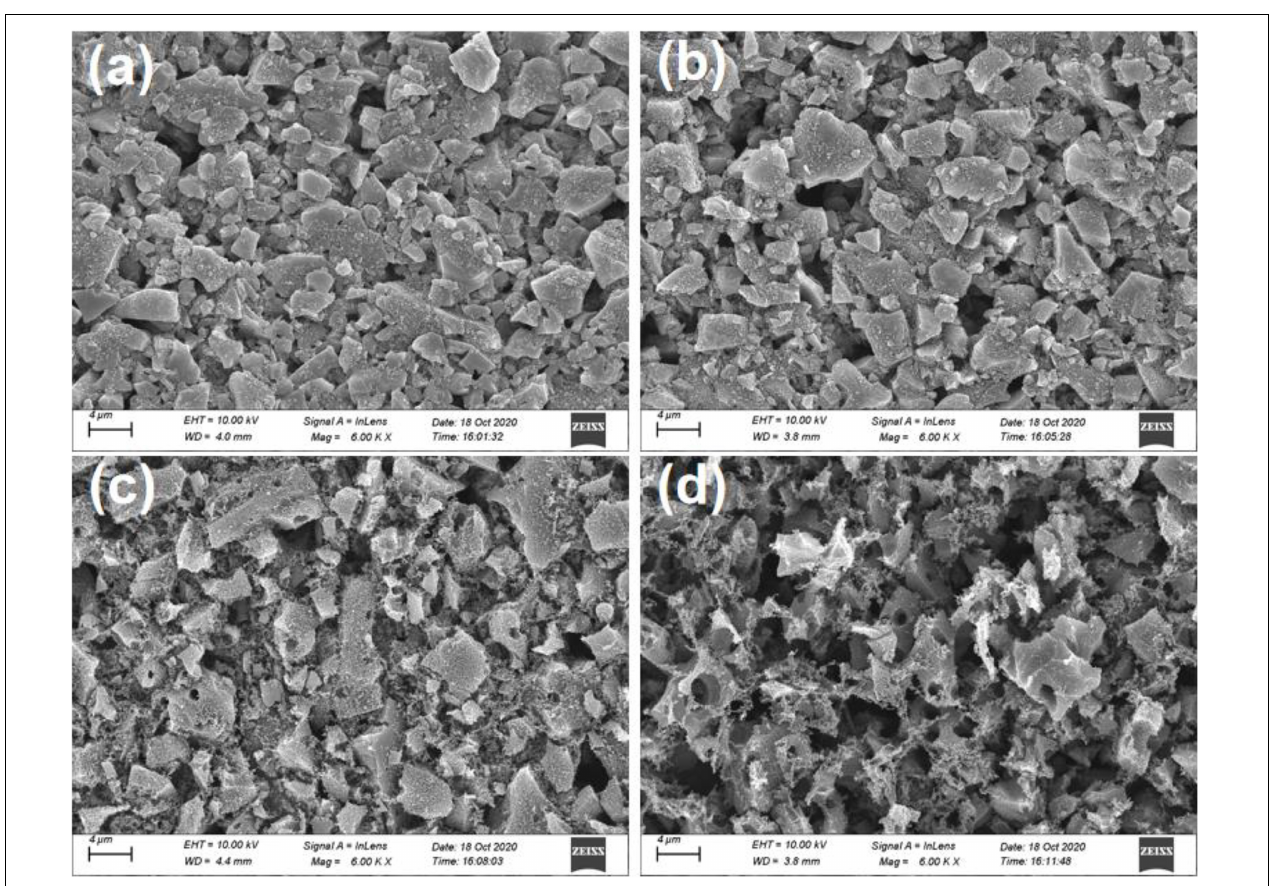
FIGURE 2 | SEM image: (a) Bare AC; (b) Oxygen-Plasma treatment at 5 min (OP-5); (c) Oxygen-Plasma treatment at 15 min (OP-15); and (d) Oxygen-Plasma treatment at 30 min